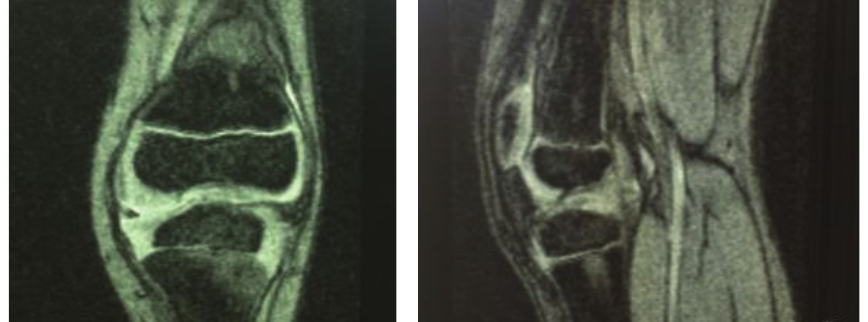
Figure 3: MRI of right knee.